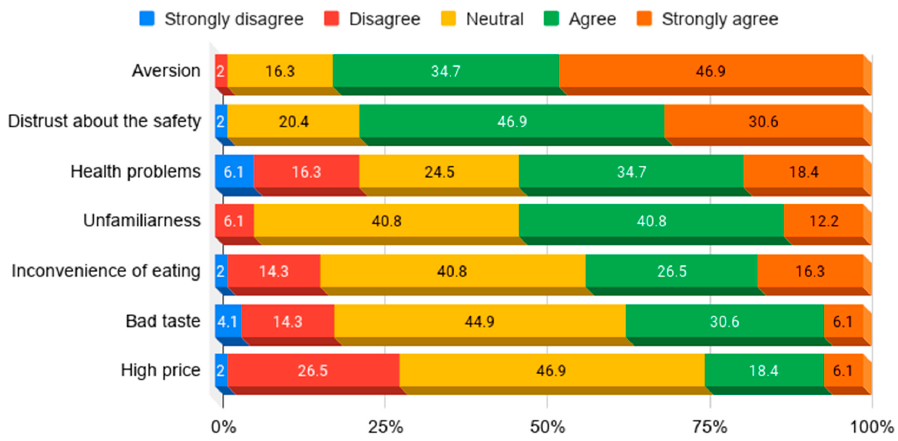
Figure 3. Reasons not to supply insect medical foods to users.